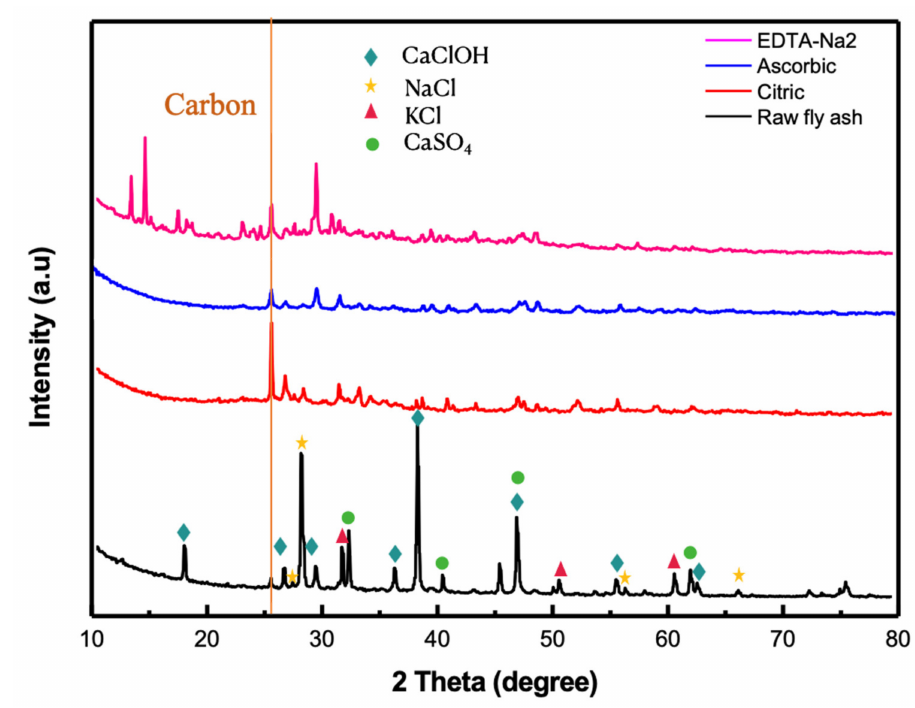
Figure 7. XRD patterns of fly